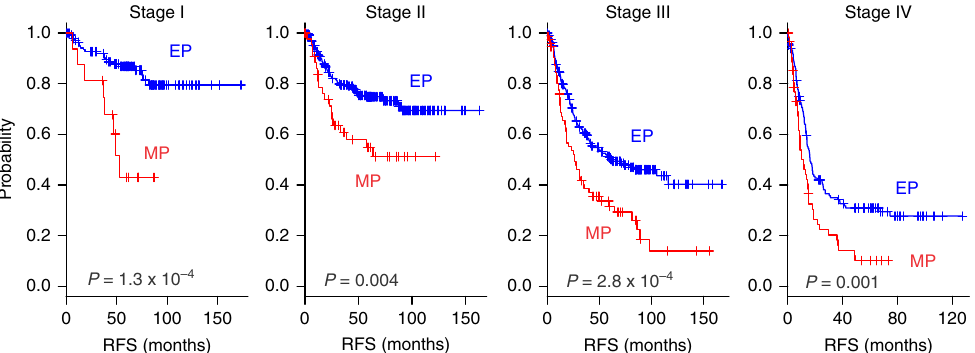
Fig. 3 Prognostic signi fi cance of mesenchymal phenotype (MP) independent of AJCC stages. When patients were strati fi ed according to stages in the pooled cohort (KUGH, YUSH, KUCM, SMC, and ACRG in total of n = 999), MP remained associated with poor prognosis regardless of stages. P values were obtained using the log-rank test. The + symbols in the panels indicate censored data. EP epithelial phenotype, MP mesenchymal phenotype, RFS recurrence-free